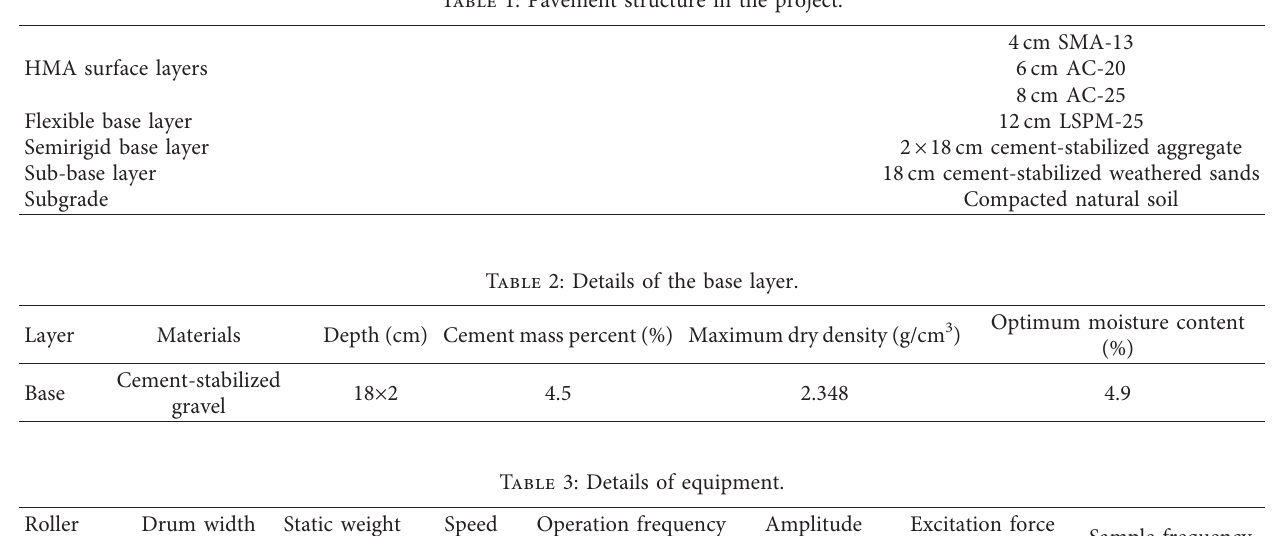
Table 1: Pavement structure in the